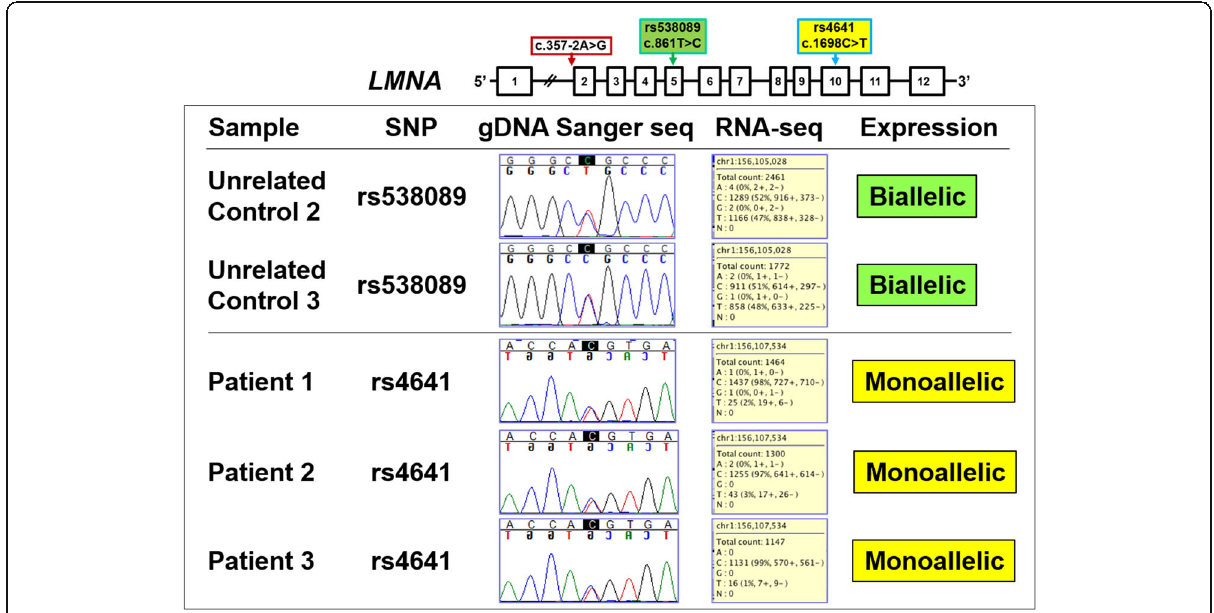
Fig. 3 LMNA allelic expression. Top panel depicts location of the LMNA splice-site mutation and two expressed single nucleotide polymorphisms (SNP), rs538089 in Exon 5 and rs4641 in Exon 10. Bottom table shows Sanger sequencing chromatograms from genomic DNA (gDNA) and distribution of allele read counts from RNA-seq. For two Unrelated Controls at rs538089, gDNA was heterozygous (C/T) with equal RNA-seq reads of C (51 – 52%) and T (47 – 48%) consistent with biallelic expression. For three Patients at rs4641, gDNA was heterozygous (C/T) with RNA-seq reads predominately of C (97 – 99%) consistent with monoallelic